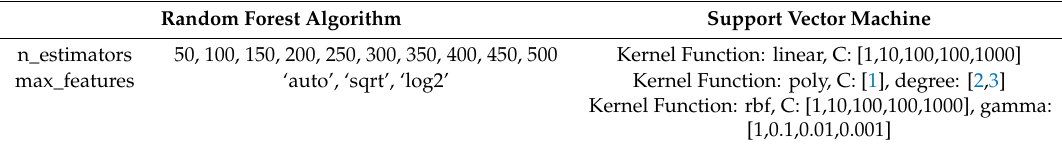
Table 2. Parameter group setting details in parameter tuning.